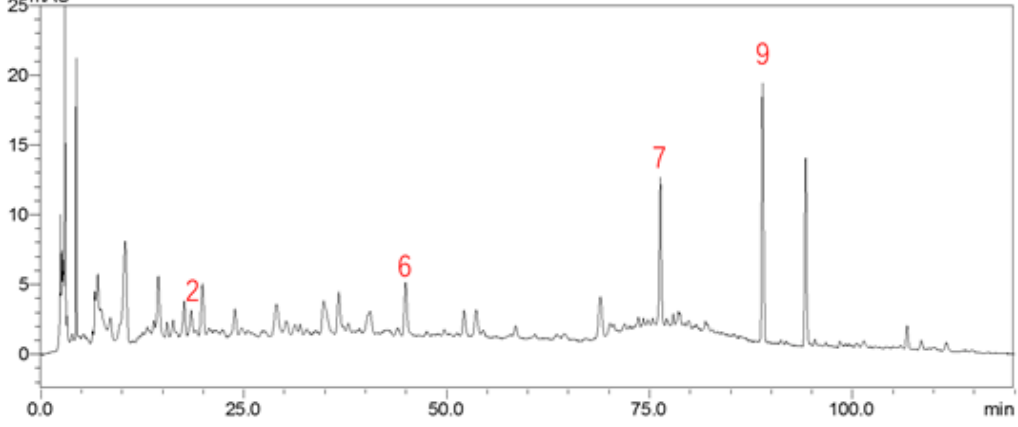
Figure 7. HPLC chromatogram of the fruit of C. fistula involving four quantitative components (2. ( − )-epicatechin; 6. sennoside A; 7. naringenin; 9. rhein).